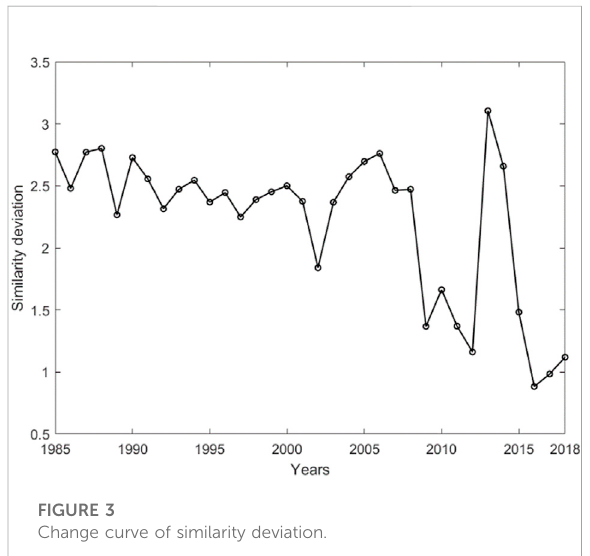
FIGURE 3 Change curve of similarity deviation.